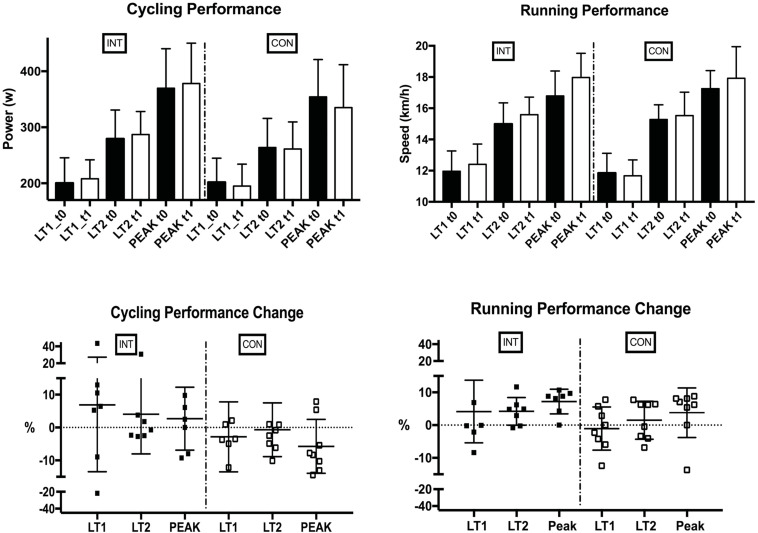
Cycling and running performance, as well as performance differences, during the study period in the Intervention and Control group, displayed as t0 = solid blocks, t1 = transparent blocks. LT, lactate threshold; Peak, peak performance, INT, intervention; CON, control group.